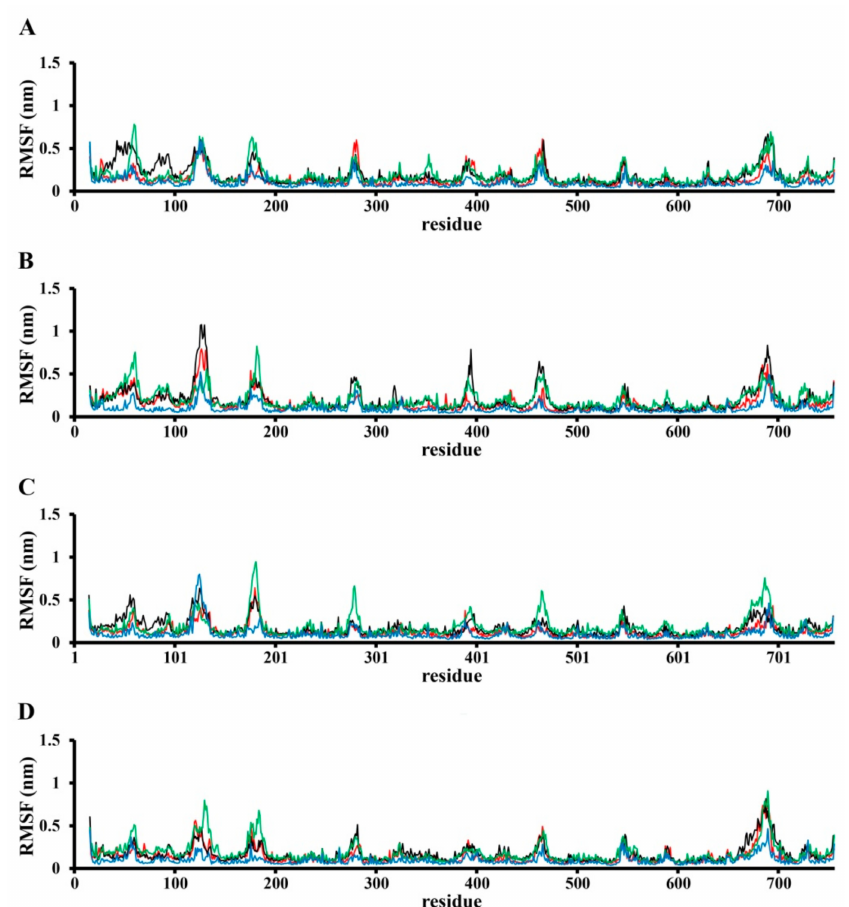
Figure 4. The root–mean–square fluctuation (RMSF) profile of the TRPC4 channel alone (in red; ( A – D ) subunits) and in complex with SWCNTs: the SWCNT_1 model is shown in black, SWCNT_2 model in green and SWCNT_3 model in